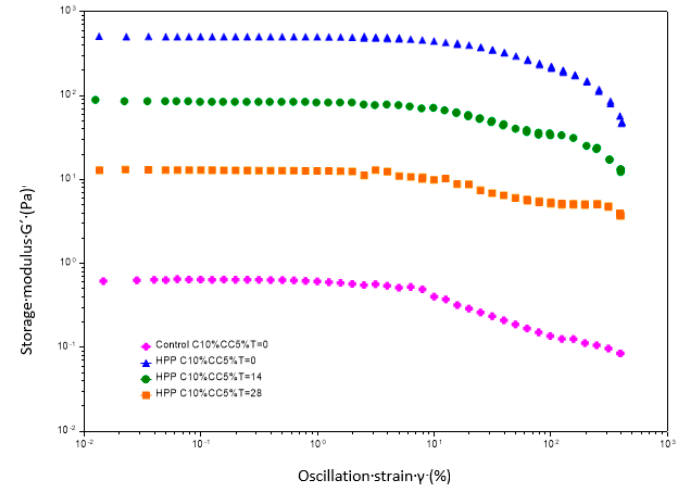
Figure 1. Amplitude sweep curves of storage modulus (G`) for the control sample and treated samples at different sampling times. Legend : HPP − High-pressure processing; C10%CC5 % − Casein 10 %, Cocoa 5%; T = 0, T = 14, T = 28. Different storage times at time 0, 14 days and 28 days.